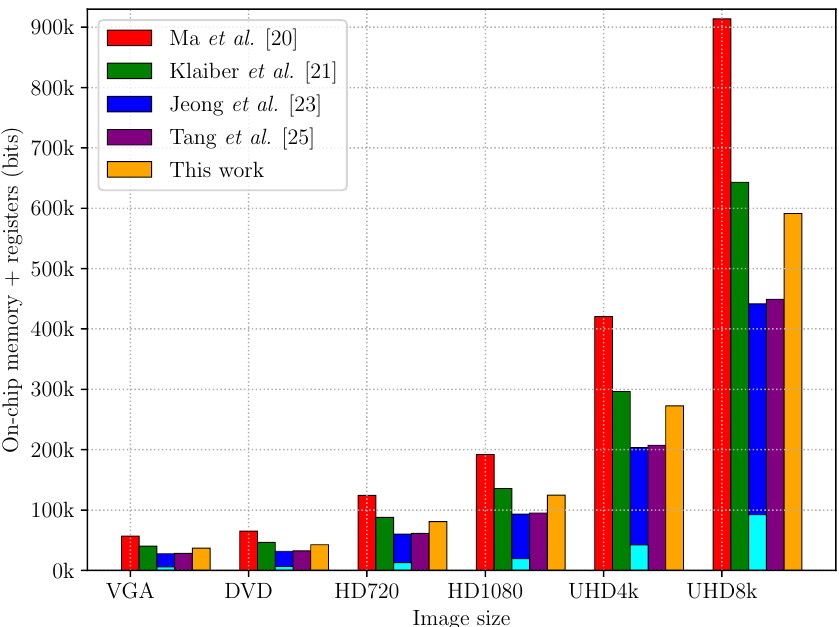
Figure 16. The bar diagram shows the number of on-memory and register bits that are required to process images of different sizes. The bars indicate on-chip memory. The cyan coloured part of [23] indicates the registers required for the row